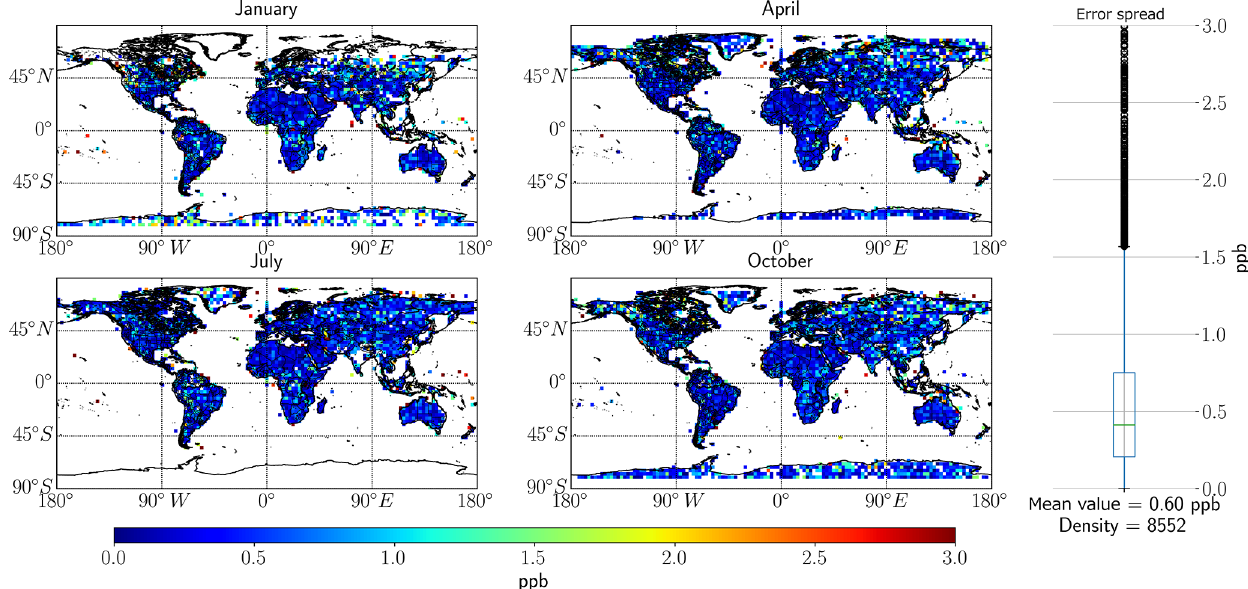
Figure 14. As Figs. 4 and 10 but focused on the Sentinel-5 SWIR1 and SWIR3